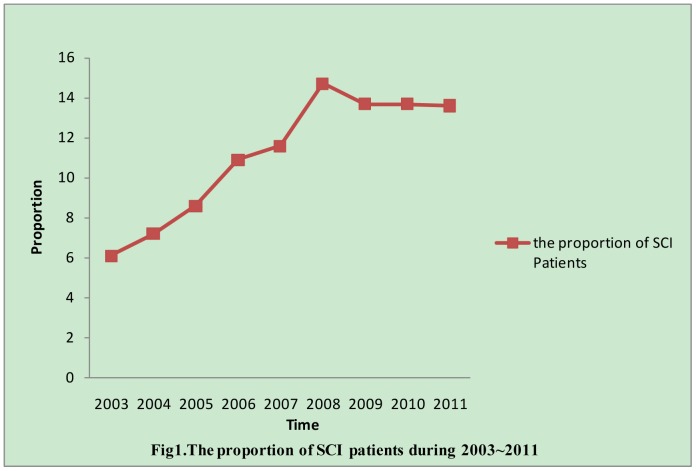
The proportion was calculated by dividing the number of SCI patients each year by the total number n (n = 3832).